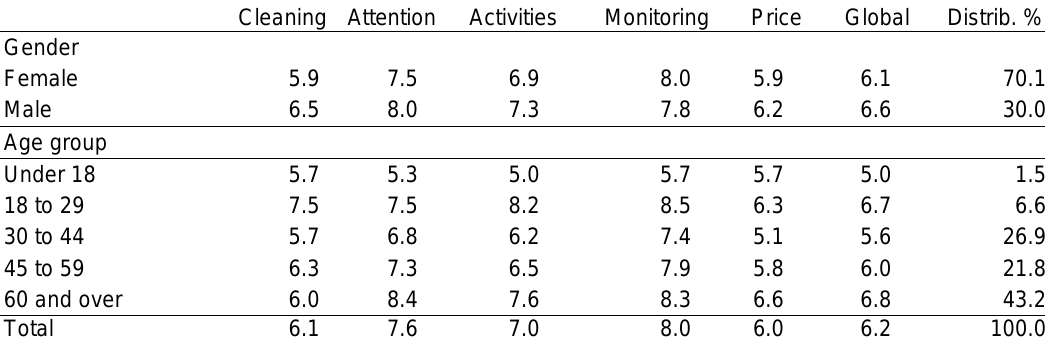
Table 13. Assessment of sports facilities by gender and age group (2017). Fum d’Estampa sports facility. Cleaning Attention